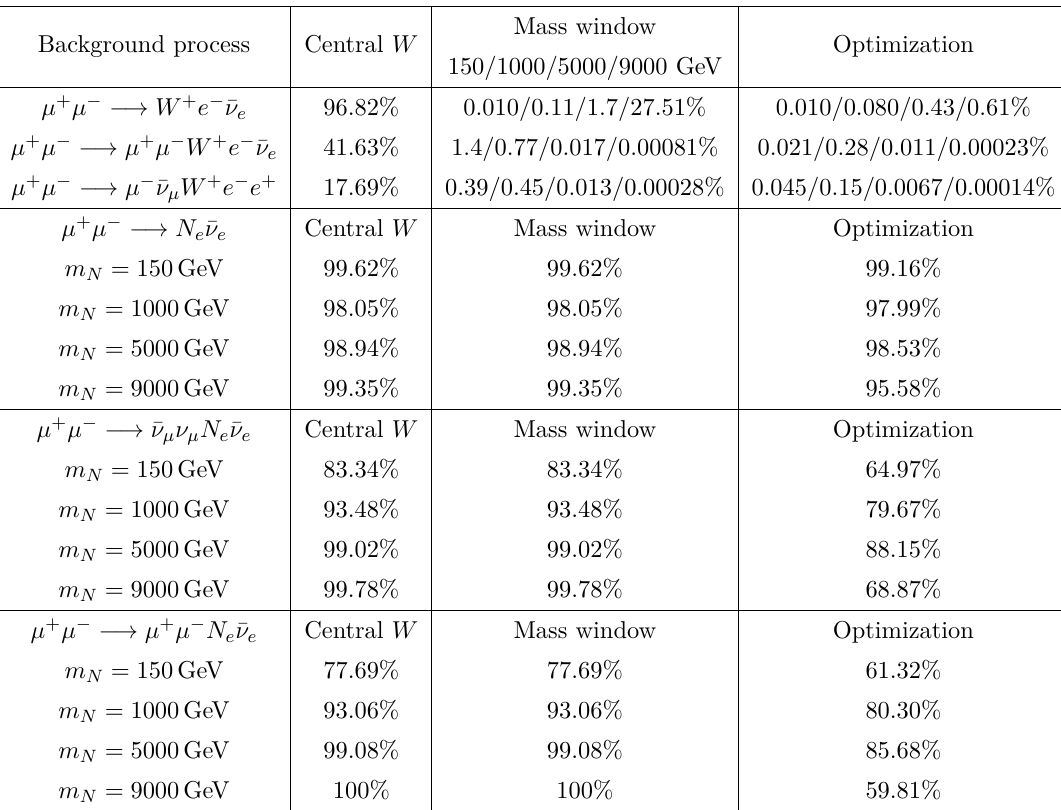
Table 13 . Cutflow table for N e at 10 TeV. All processes after pre-selection is set to